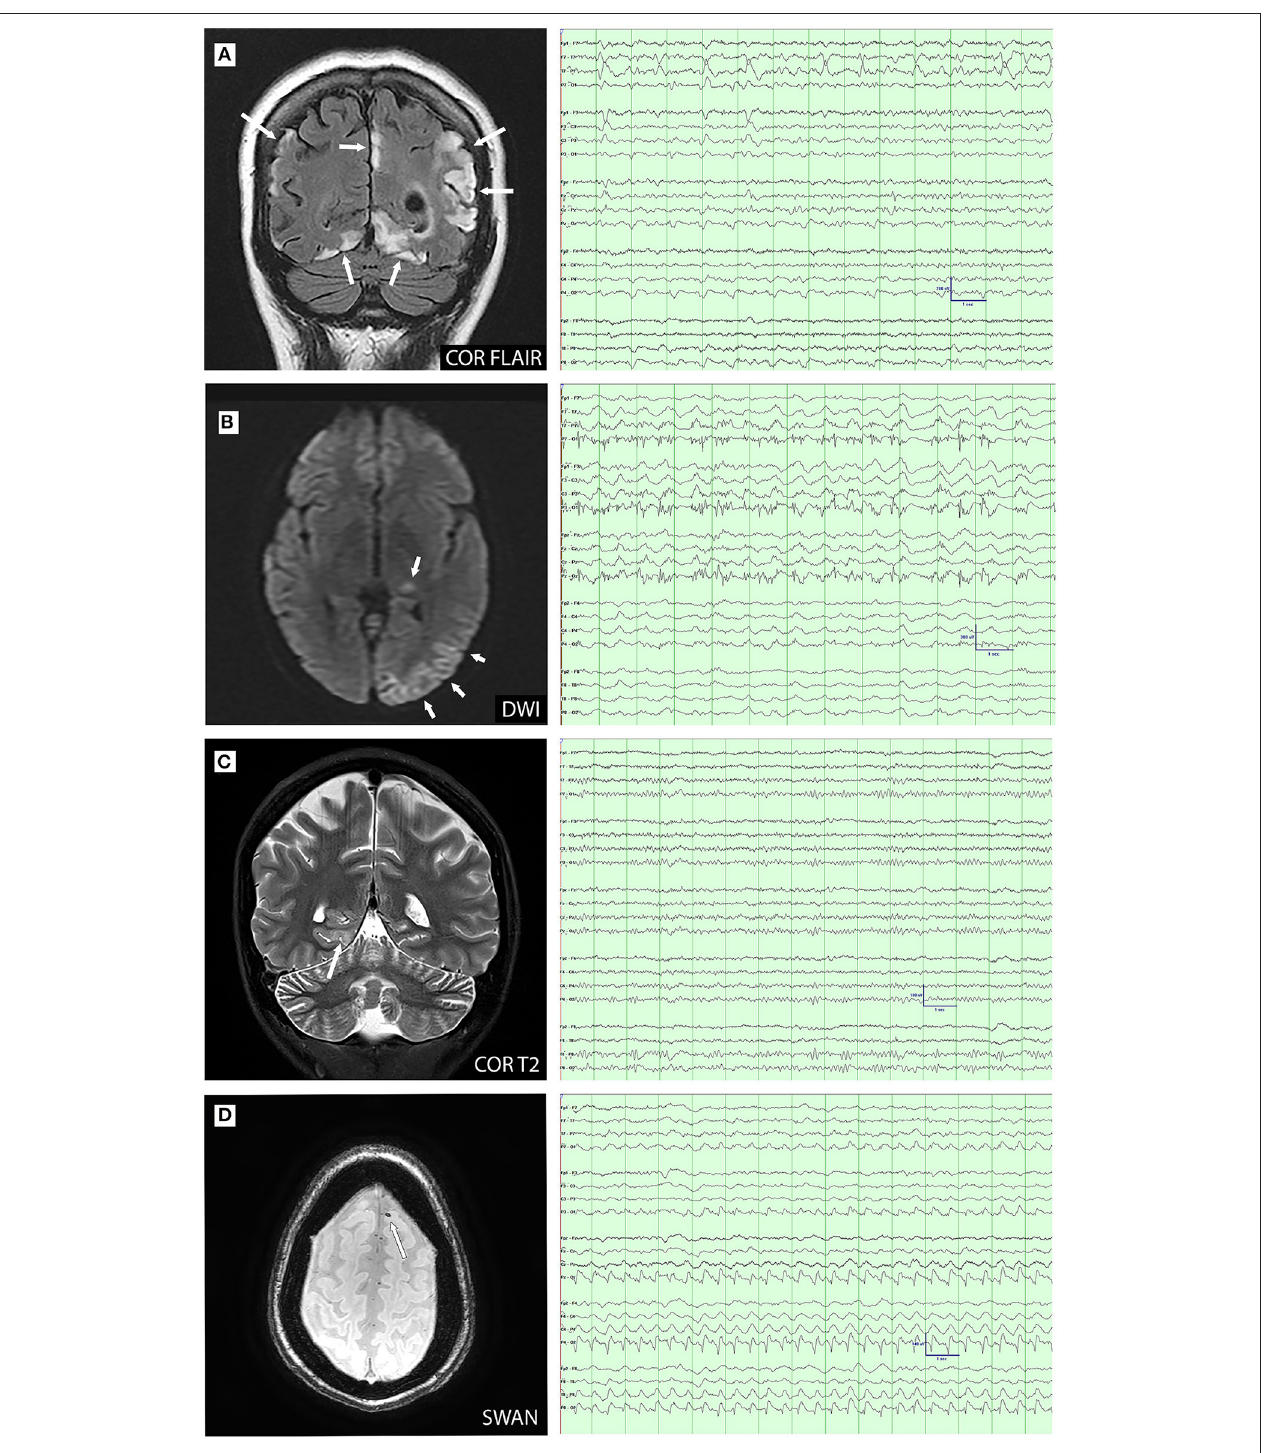
FIGURE 3 | MRI-electroencephalogram (EEG) concordance (A–C) and discordance (D) comparisons. (A) : Coronal FLAIR image demonstrates cortical and subcortical hyperintensity in the parietal and occipital lobes. EEG demonstrates left temporal lateral periodic discharges and bioccipital spikes; (B) : Diffusion-weighted imaging (DWI) demonstrates restriction in the left pulvinar and temporo-occipital cortex. EEG shows ongoing electrographic seizure activity over the left posterior temporal and occipital; (C) : Coronal T2 image demonstrates cortical hyperintensity in the right medial occipitotemporal gyrus. EEG shows right posterior temporal slowing with increased right posterior region amplitudes; and (D) : Axial susceptibility-weighted angiography (SWAN) image demonstrates susceptibility artifact consistent with microhemorrhage in the left superior frontal gyrus. EEG demonstrates right posterior lateralized periodic discharges.